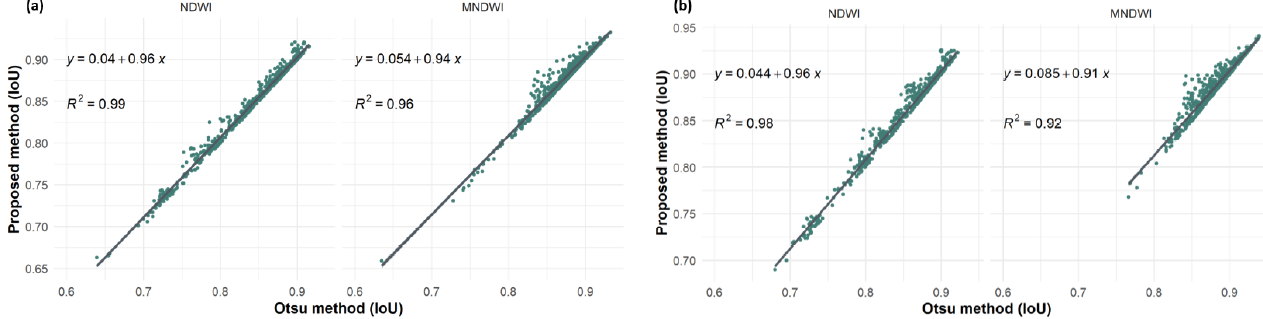
Figure 11. Plots of IoU correlation between the proposed method and the Otsu method: ( a ) path 153 and ( b ) path